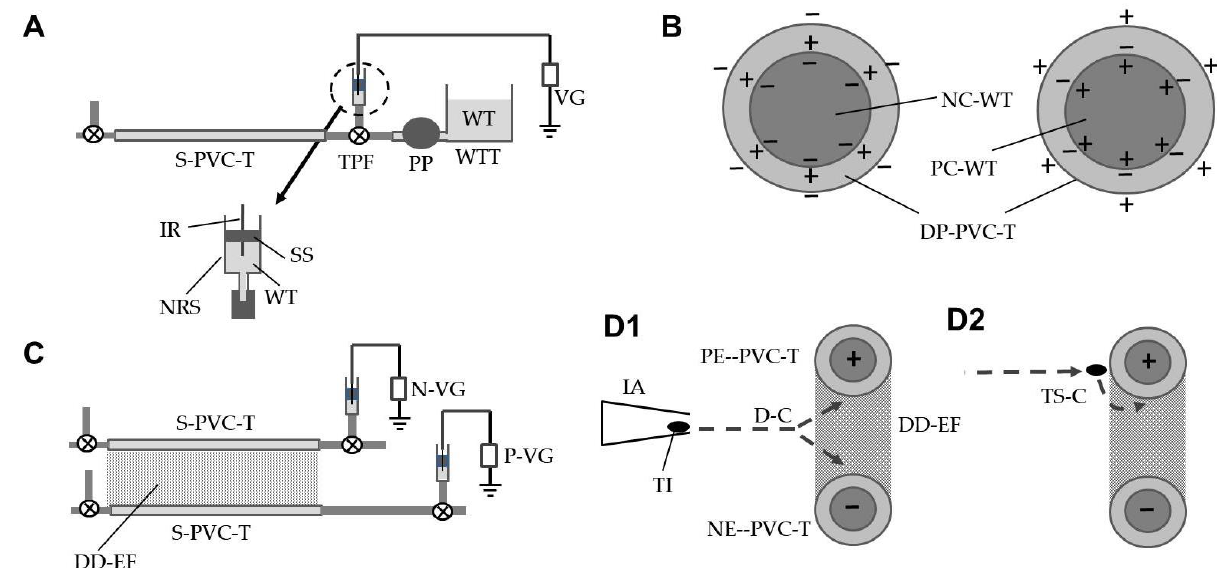
Figure 1. ( A ) Preparation of a soft polyvinyl chloride tube (S-PVC-T) filled with charged water. ( B ) Dielectric polarization of an S-PVC-T caused by the presence of negatively or positively charged water in the tube (cross-sectional view). ( C ) Formation of a double-charged dipolar electric field by a pair of oppositely charged PVC tubes. ( D1 ) Insect capturing with the DD electric field (cross-sectional view) through a direct approach or ( D2 ) a two-step approach. Dotted arrow depicts the path of an insect blown inside the DD electric field. Abbreviations: S-PVC-T, soft polyvinyl chloride tube; TPF, T-shaped acrylic pipe fitting with a channel-switching cock; PP, peristaltic pump; WT, water; WTT, water tank; VG, grounded voltage generator; IR, iron wire; NRS, needle-removed syringe; SS, silicone stopper; DP-PVC-T, dielectrically polarized PVC tube; NC-WT, negatively charged water; PC-WT, positively charged water; N-VG, negative voltage generator; P-VG, positive voltage generator; DD-EF, double-charged dipolar electric field; PE-PVC-T, positively electrified PVC tube; NE-PVC-T, negatively electrified PVC tube; IA, insect aspirator; TI, test insect.